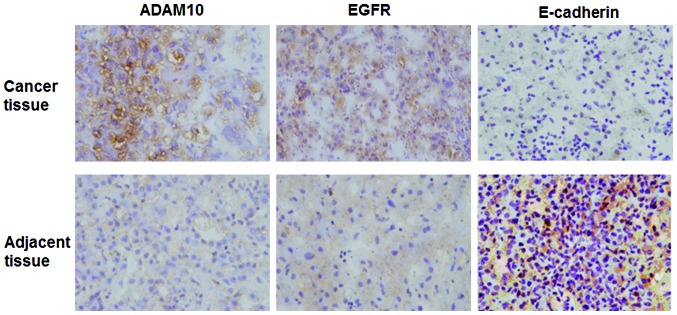
Immunohistochemical analysis of a disintegrin and metalloproteinase 10 (ADAM10), epidermal growth factor receptor (EGFR) and E-cadherin expression in hepatocellular carcinoma and the adjacent tissue (magnification, ×200). A positive biopsy in the kit was used for the staining of the positive control and the antibody was replaced by phosphate-buffered saline for the staining of the negative control. Yellow to brownish-yellow granules in the cells were considered to indicate positive cells. Positive cells were counted in a total of 100 cells using high-power microscopy, and scored according to the positive expression rate (0 points for <10%; 1 point for 11–20%; 3 points for 21–50%; 4 points for >50%) and staining intensity (0 points for no staining; 2 points for weak; 3 points for strong). The sum of the points for staining intensity and positive expression rate was used as the expression score. A score ≥3 was considered to indicate a positive case and a score of 0–2 was classified as a negative case.